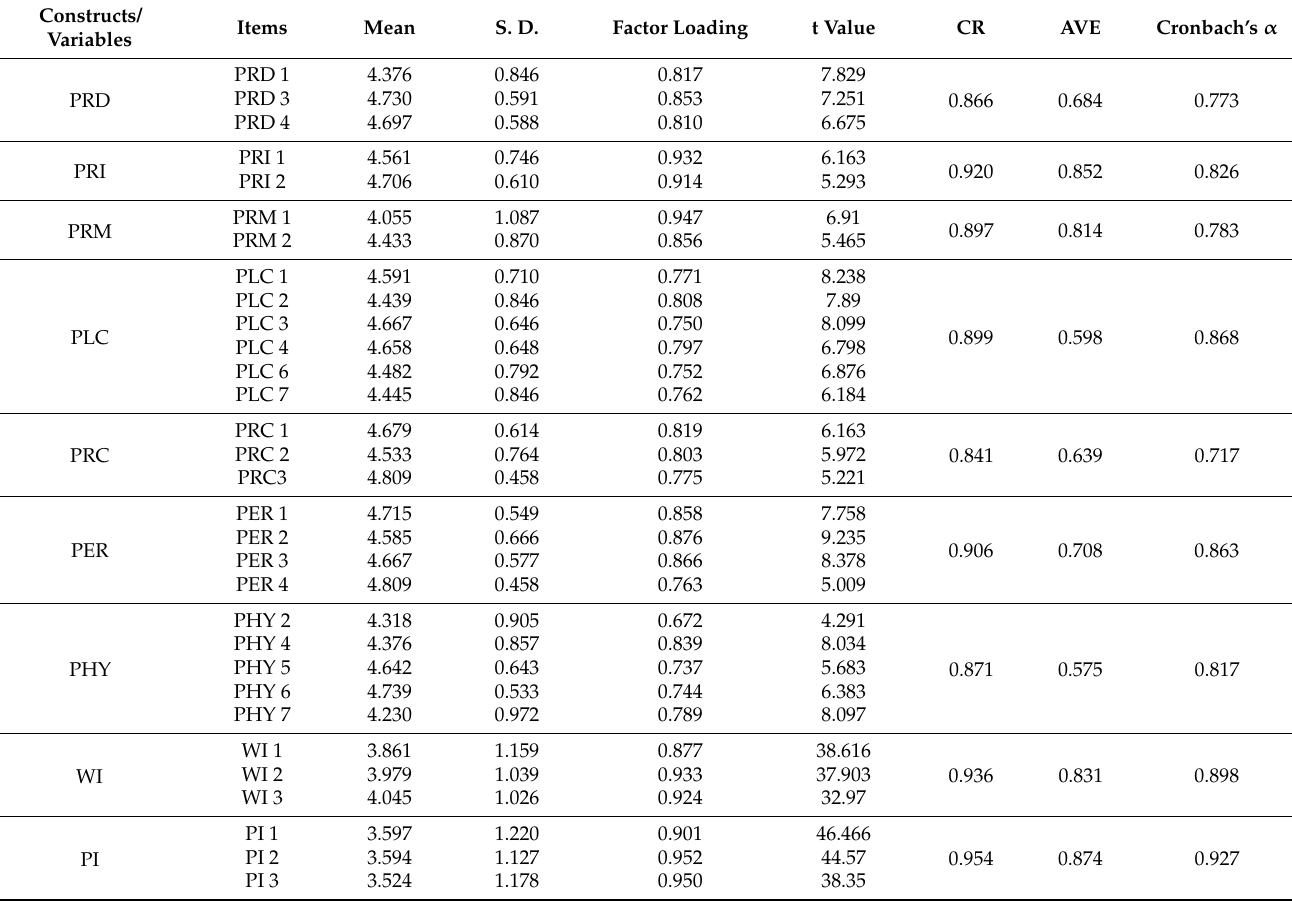
Table 2. Estimation results of measurement model ( n = 330).